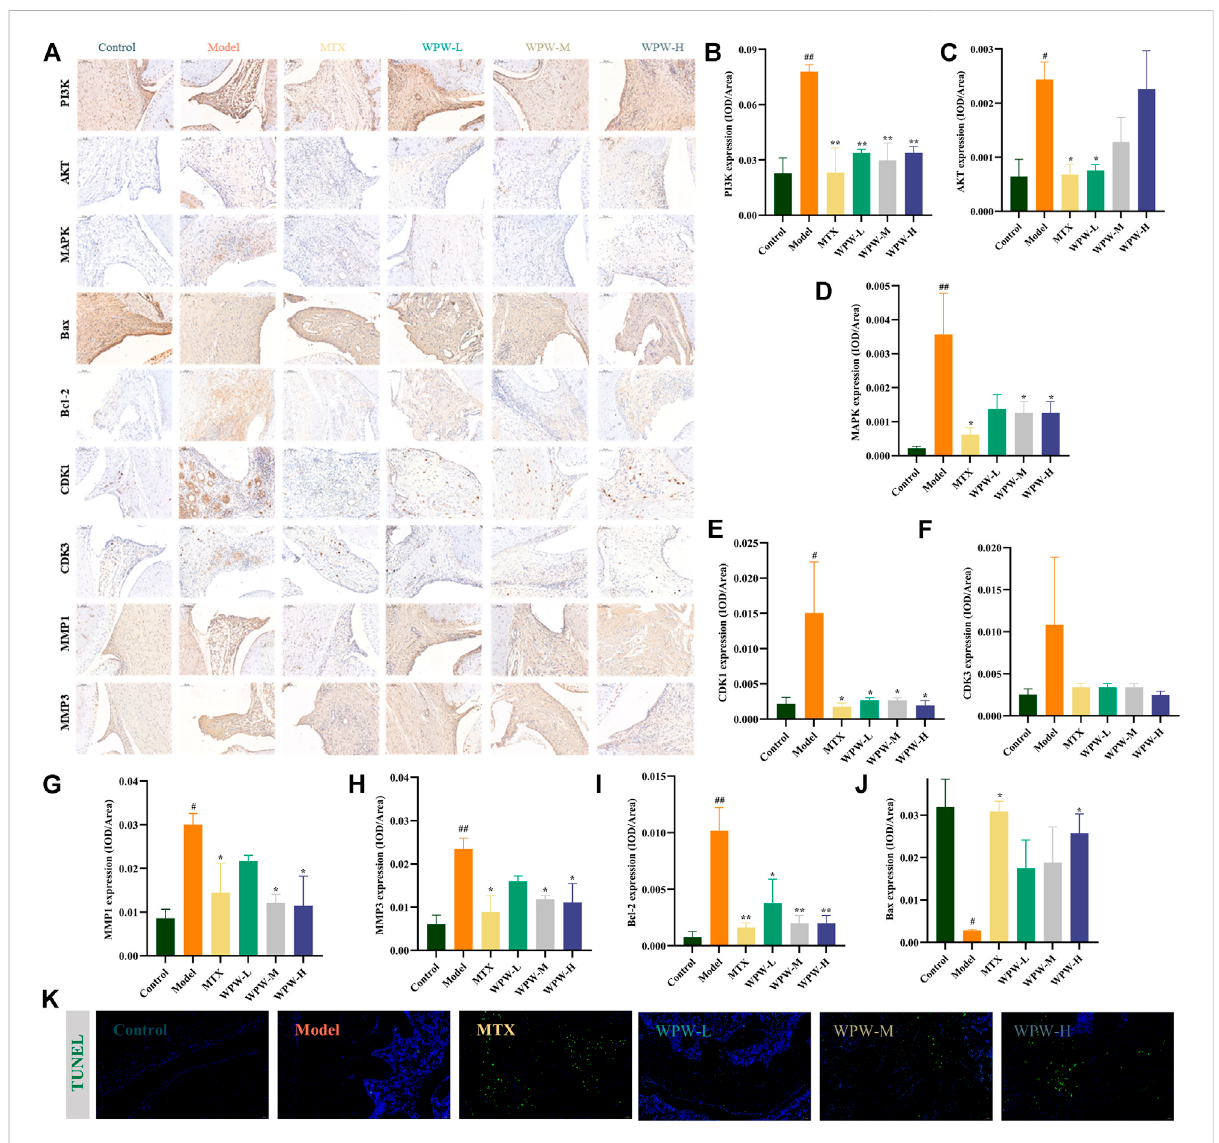
FIGURE 6 Effect of WPW on protein expression in thesynovial region of the ankle joint in AA rats. (A) The expression levels of PI3K, AKT, MAPK, Bax, Bcl-2, CDK1, CDK3, MMP1, and MMP3 in arthritic joints were detected by the immunohistochemical method (n = 3; Magni fi cation: ×200; Scale